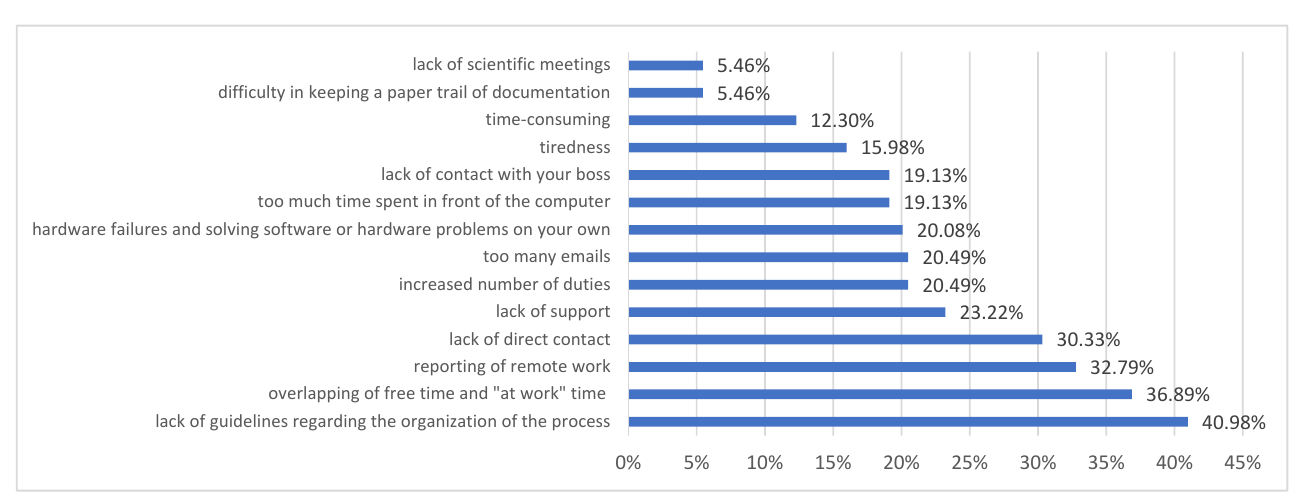
Figure 4. The disadvantages of remote work indicated by the respondents.